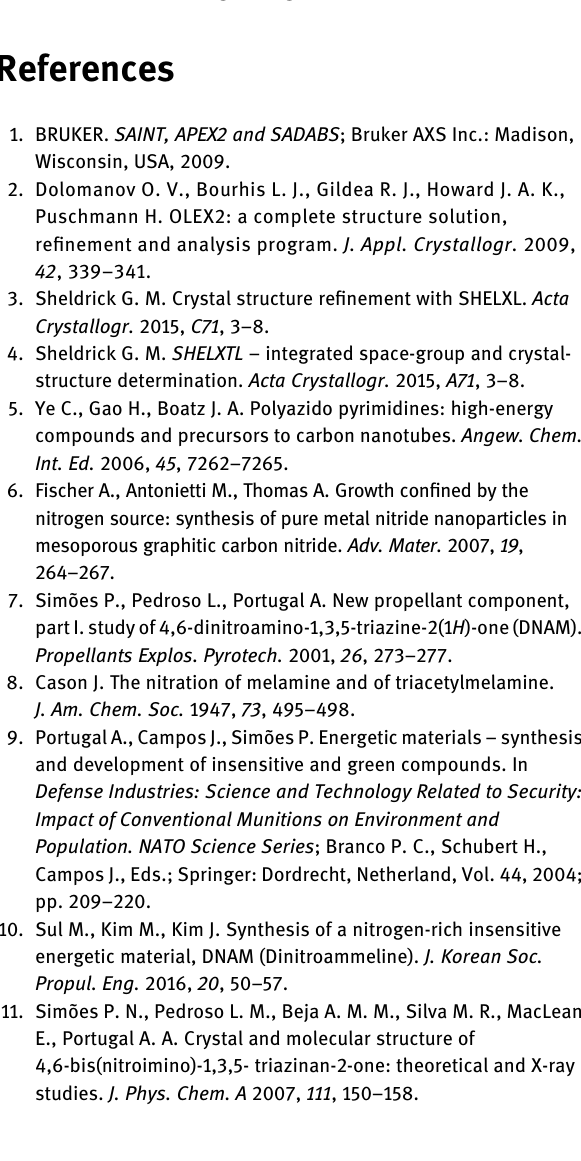
complexes as cations. All bond length and bond angles are in the normal range [11]. Compared with the DNAM crystal structure, the bond length and angle are slightly changed. The dihedral angle between the nitro group N7-O5-O4 and the azine ring is increased from 10.05 ° to 24.80 ° , and the dihedral angle between the nitro group N1-O2-O3 and the azine ring is reduced from 10.05 ° to 5.14 ° .